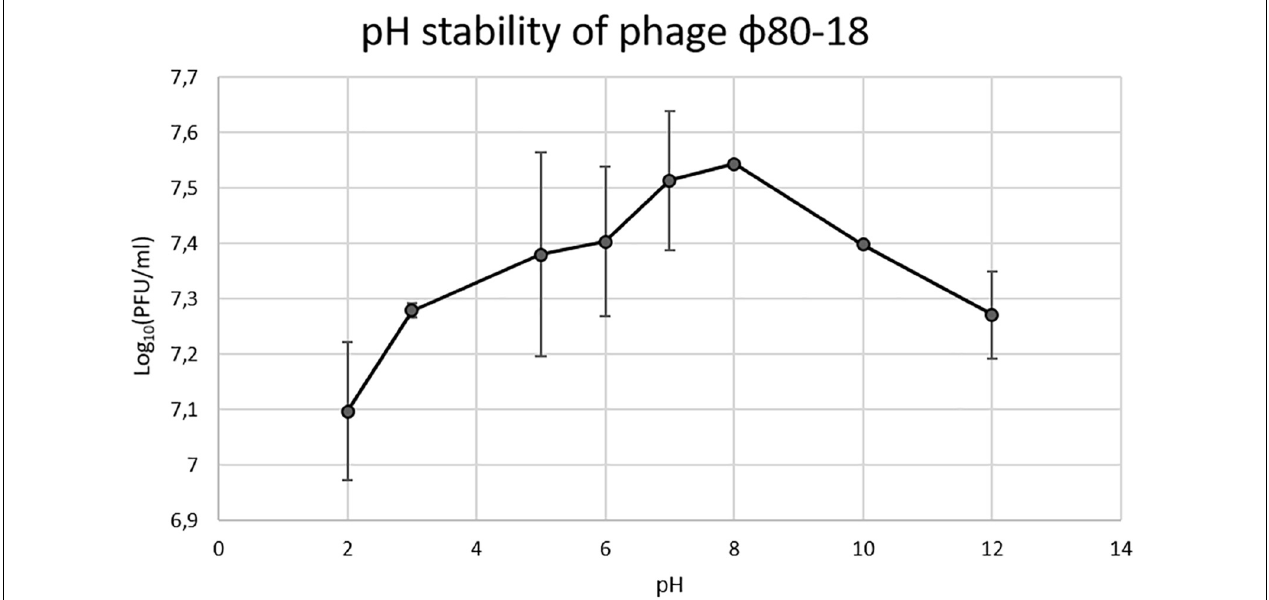
FIGURE 7 | pH stability of bacteriophage φ 80-18.